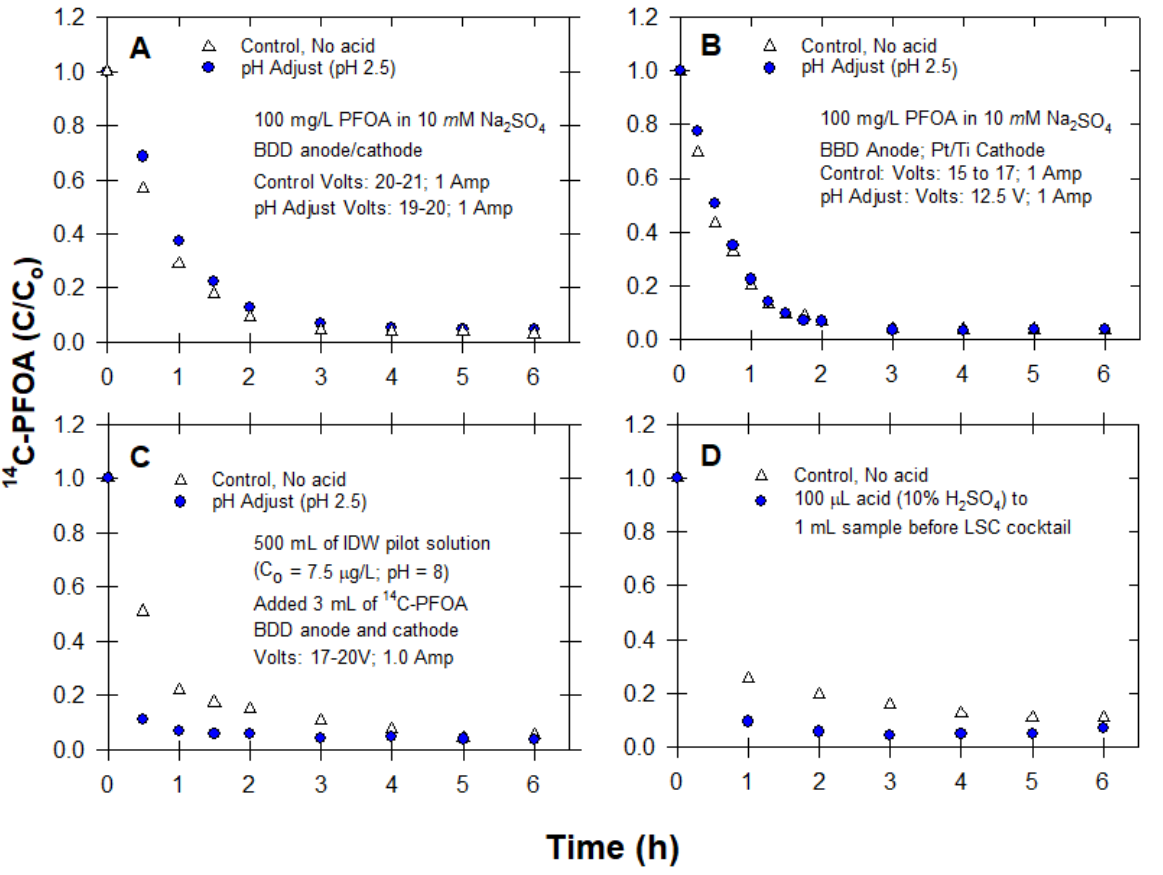
Figure 3. ( A ) Effect of pH adjustment on PFOA kinetics; ( B ) degradation of 14 C-PFOA with BDD anode and Pt/Ti cathode, with and without pH adjustment; ( C ) degradation of 14 C-PFOA in alkaline PFOA solution (pH 8) with BDD anode and cathode, with and without pH adjustment (pH adjust = 2.5); ( D ) effects of acidifying samples before mixing with liquid scintillation counting (LSC) cocktail.